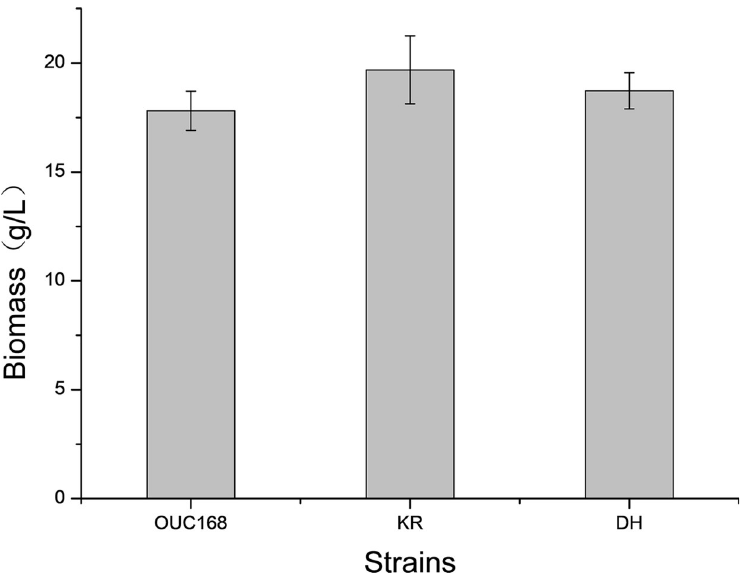
Fig 7. Biomass of strains A . limacinum KR, A . limacinum DH and A . limacinum OUC168. All data are expressed as means ± SD (n = 3).